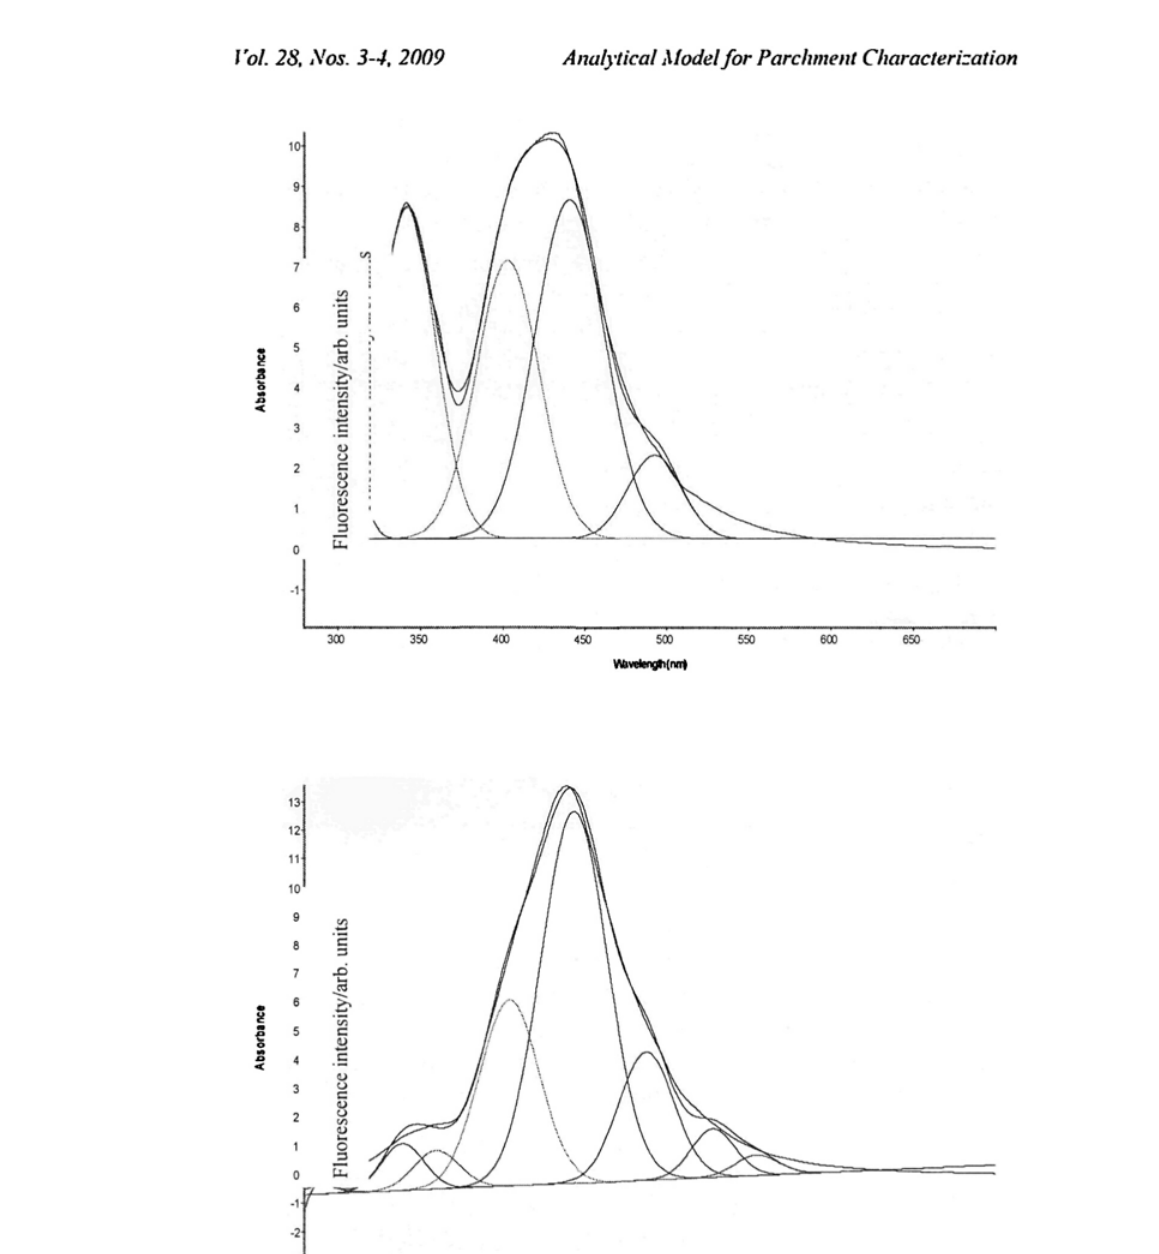
Fig. 35: Examples of deconvolution of modern (top) and historical (bottom) parchment